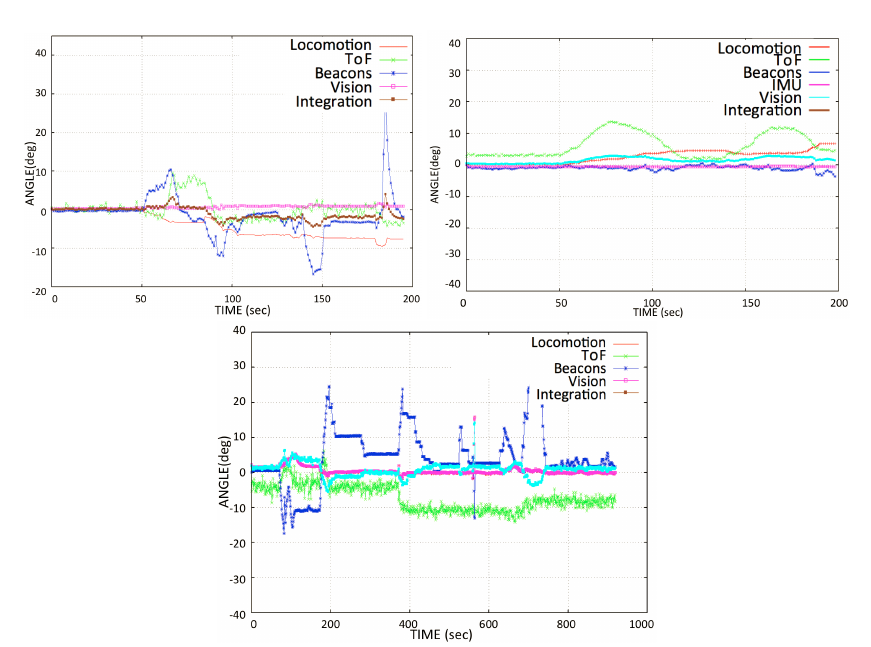
Figure 22. Orientation error with respect to the VN-100 IMU sensor: Navigation, flat movement, and window panel transition